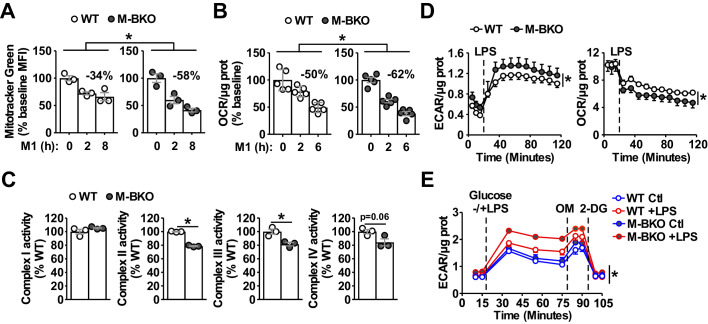
Bmal1 is required to maintain mitochondrial metabolism.(A) Assessment of mitochondrial mass in macrophages throughout a time course of M1 activation using Mitotracker Green (mean fluorescence intensity, MFI) determined by flow cytometry. N = 3 biological replicates, statistical analysis was performed using two-way ANOVA for WT vs M-BKO across the time course. (B) Basal oxygen consumption rate (OCR) in Ifn-γ-primed macrophages pretreated without or with LPS (10 ng/mL) for 2 or 6 hr before the assay. See Figure 2—figure supplement 1B for the full assay results. The assay medium contained minimal DMEM with 5 mM glucose and 1 mM sodium pyruvate, pH 7.4. N = 5 biological replicates, statistical analysis was performed using two-way ANOVA for WT vs M-BKO across the time course. (C) Activities of ETC complexes in isolated mitochondria from WT and M-BKO macrophages after 6 hours M1 stimulation. N = 3 biological replicates, statistical analysis was performed using Student’s T test. (D) Extracellular flux analysis in Ifn-γ-primed macrophages measuring the changes in extracellular acidification rate (ECAR, left panel) and oxygen consumption rate (OCR, right panel) following LPS injection (100 ng/mL). The assay medium contained 5 mM glucose and 1 mM pyruvate in minimal DMEM with 2% dialyzed FBS, pH 7.4. N = 5 biological replicates, statistical analysis was performed using two-way ANOVA for WT vs M-BKO across the time course. (E) Glycolytic stress test in Ifn-γ-primed macrophages measuring ECAR following glucose (25 mM) injection, with or without LPS (100 ng/mL). Maximal glycolytic rate was determined by injection of oligomycin (OM, 2 μM), and glycolysis-dependent ECAR was determined by injection of 2-deoxyglucose (2-DG, 50 mM). The assay medium contained minimal DMEM with 2% dialyzed FBS, pH 7.4. N = 5 biological replicates, statistical analysis was performed using two-way ANOVA for WT vs M-BKO across the time course. Data are presented as mean ± S.E.M. *, p<0.05. Experiments were repeated at least twice.